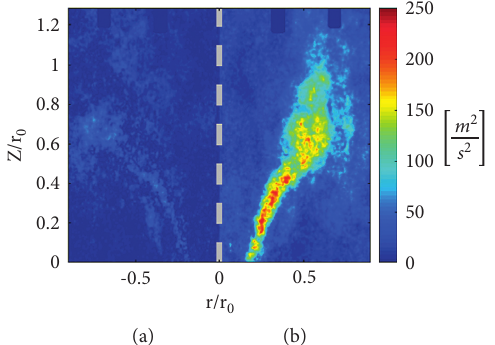
Figure 5: Comparison of the time averaged product of orthogonal components of velocity fluctuations (a) and squared axial (b) velocity fluctuation. Representative data are shown for the first phase of the instability.